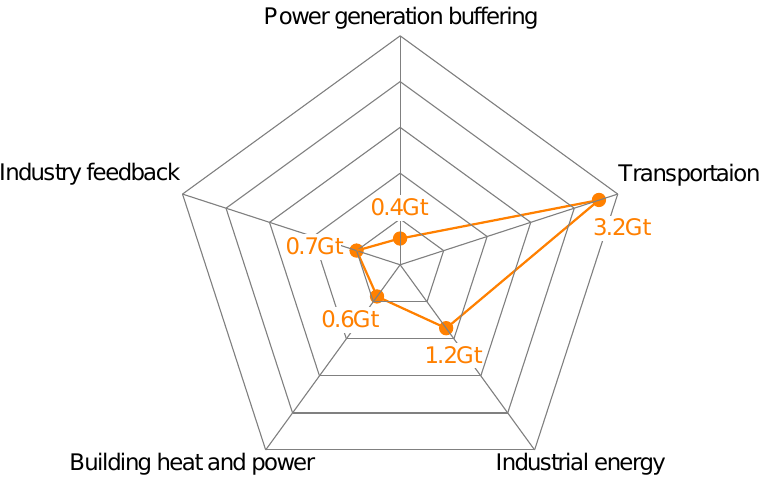
Figure 1. Carbon emission reduction by field in 2050. Table 1. Technical indicators of hydrogen fuel for proton exchange membrane (PEM) fuel cell